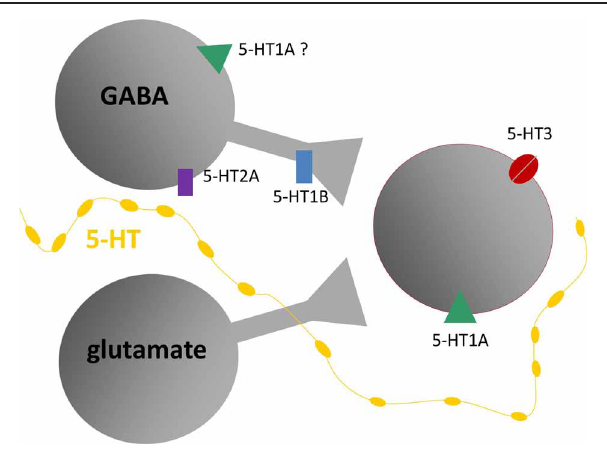
FIGURE 7 | Model of putative locations of 5-HT1A and 5-HT1B receptors relative to GABAergic and glutamatergic circuitry in the IC, based on in vivo and in vitro recordings. Gray shapes are auditory neurons that express serotonin (5-HT) receptors responding to release of serotonin by projections from raphe nuclei (yellow line). Red outline indicates neurons recorded in the IC, receiving inputs from presynaptic GABAergic and glutamatergic neurons. Diagram does not include all known types of serotonin receptors or types of inputs received by IC